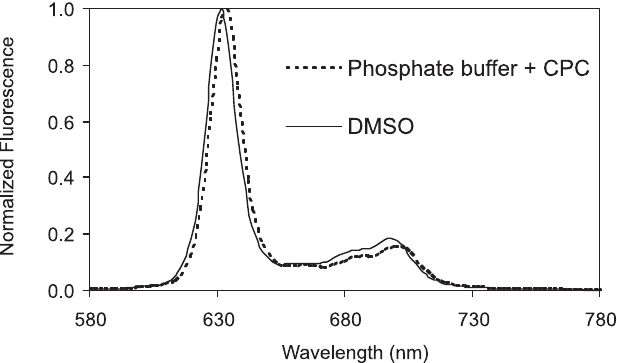
FIGURE 2 - Normalized fluorescence spectra of PpIX (2.0 μg/mL) in the solvents used for the in vitro penetration studies. Specifications: λ excitation (nm) = 400/λ 632 and 634; excitation/emission Slits: 5.0/5.0